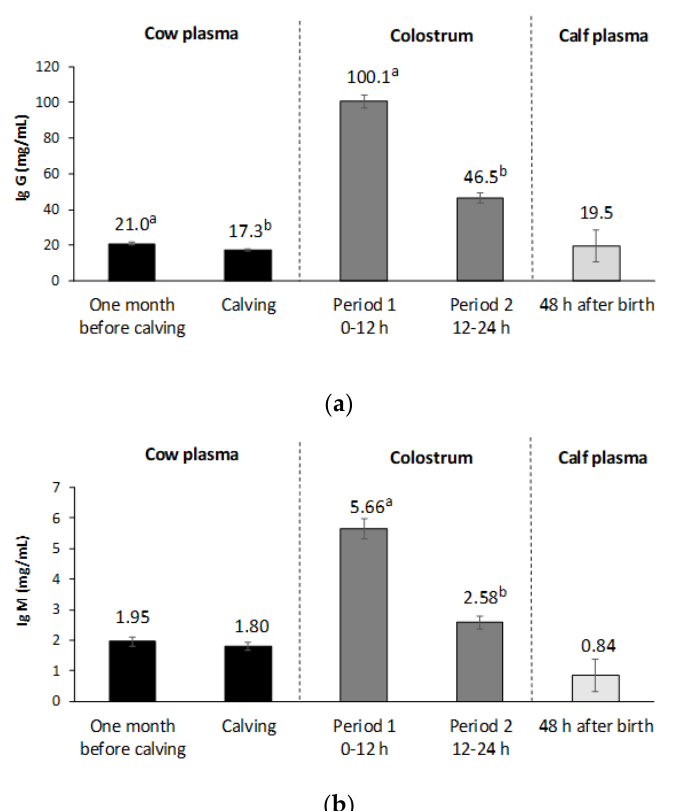
Figure 1. ( a ) Mean IgG concentrations in dam plasma, colostrum and calf plasma in the peripartum. ( b ) Mean IgM concentrations in dam plasma, colostrum and calf plasma in the peripartum. a,b Means with different superscripts between cow plasma or between colostrum samples differ significantly ( p < 0.05).